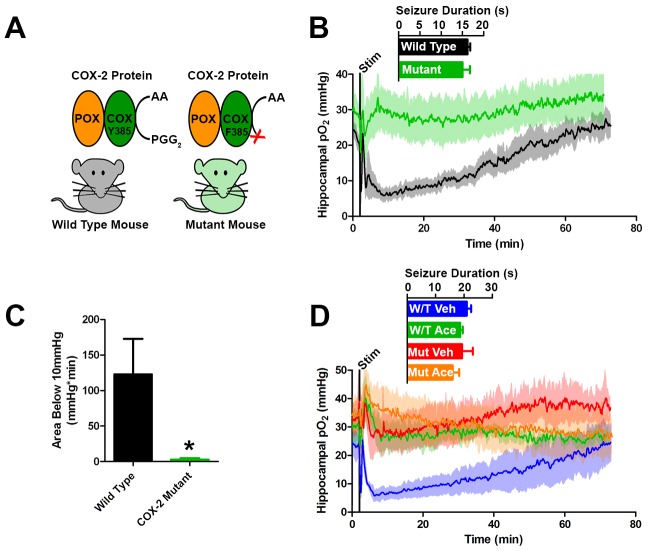
Genetic knockdown of COX-2 function prevents postictal severe hypoxia.(A) COX-2 proteins from wild-type and mutant mice (PTGS2Y385F) displayed as a schematic. Both mice have functional peroxidase (POX). Mutants have a point mutation in the cyclooxygenase (COX) active site, which prevents the conversion of arachadonic acid (AA) to prostaglandin G2 (PGG2). (B) No differences were observed in seizure duration between wild-type and mutant mice (n = 4). Wild-type mice displayed severe postictal hypoxia, while mutant mice remained normoxic in the postictal period. (C) Quantification of (D). COX-2 mutant mice displayed a significant reduction in severe hypoxia (area below 10 mmHg). *p<0.05 (t-test). (E) Wild-type and mutant mice were treated with acetaminophen (250 mg/kg) (n = 3). Acetaminophen prevented hypoxia in wild-type mice and had no effect in mutant mice.